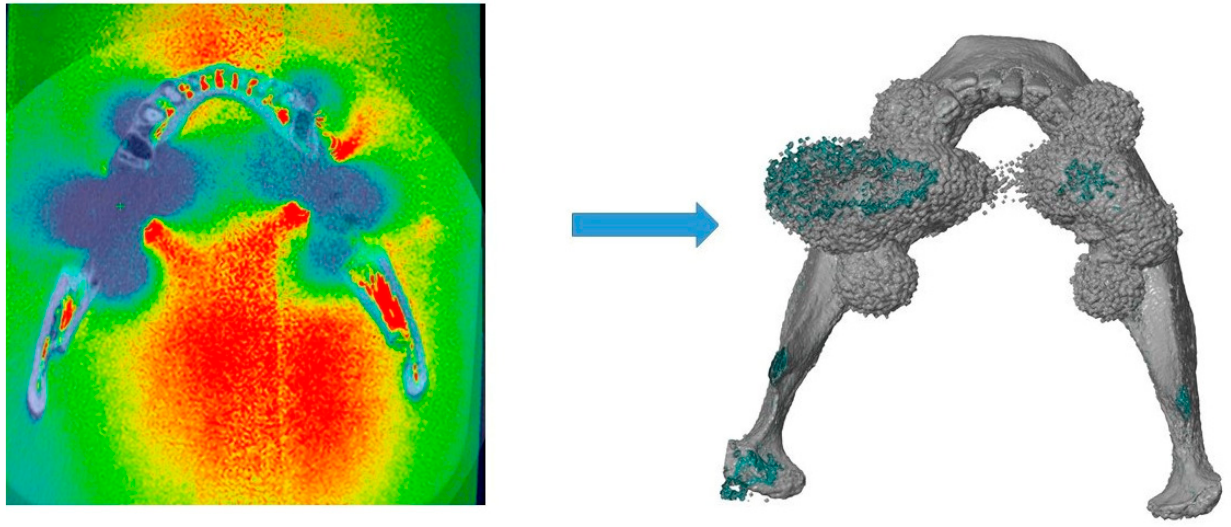
Figure 2. Artifacts segmentation and 3D rendering. Dark areas represent artifacts, which were converted in a three-dimensional model combined with the mandible. Mandibular volume increase was assessed to determine the artifacts dimension.